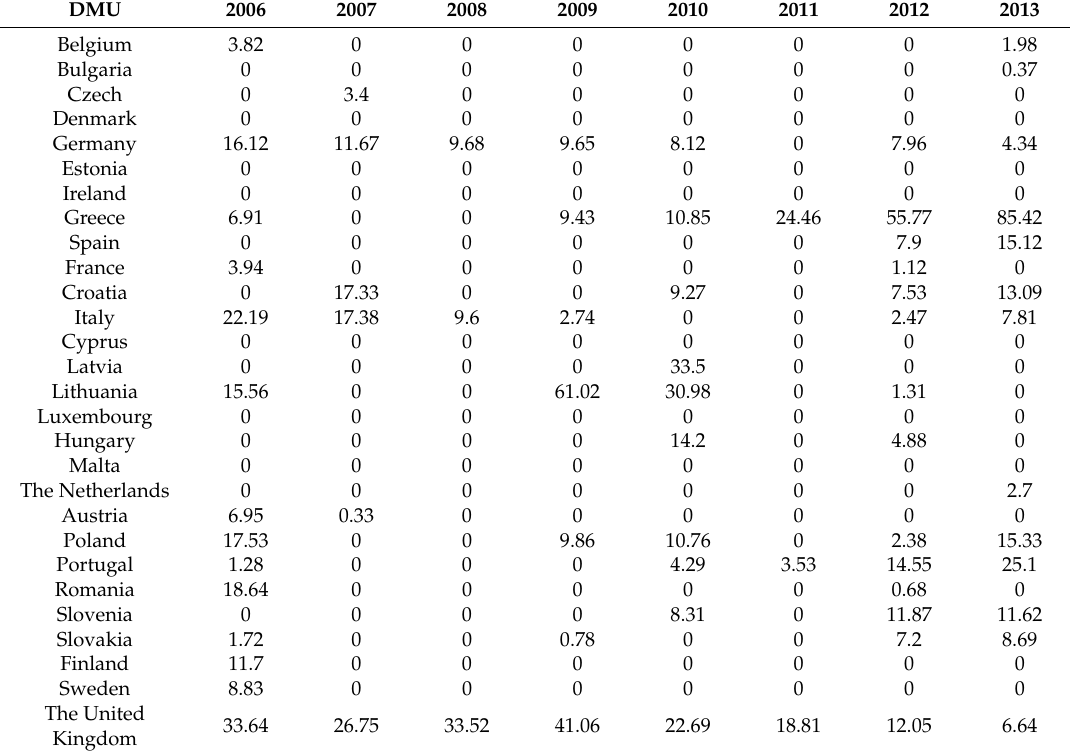
Table 7. The carry-over adjustment percentage of all EU countries. Unit: